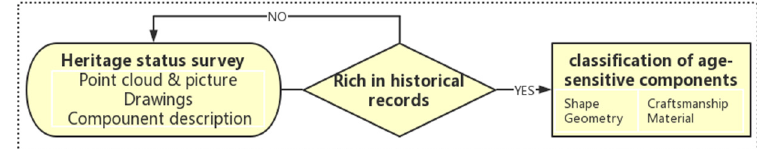
Figure 5. Survey and classification of shape features.